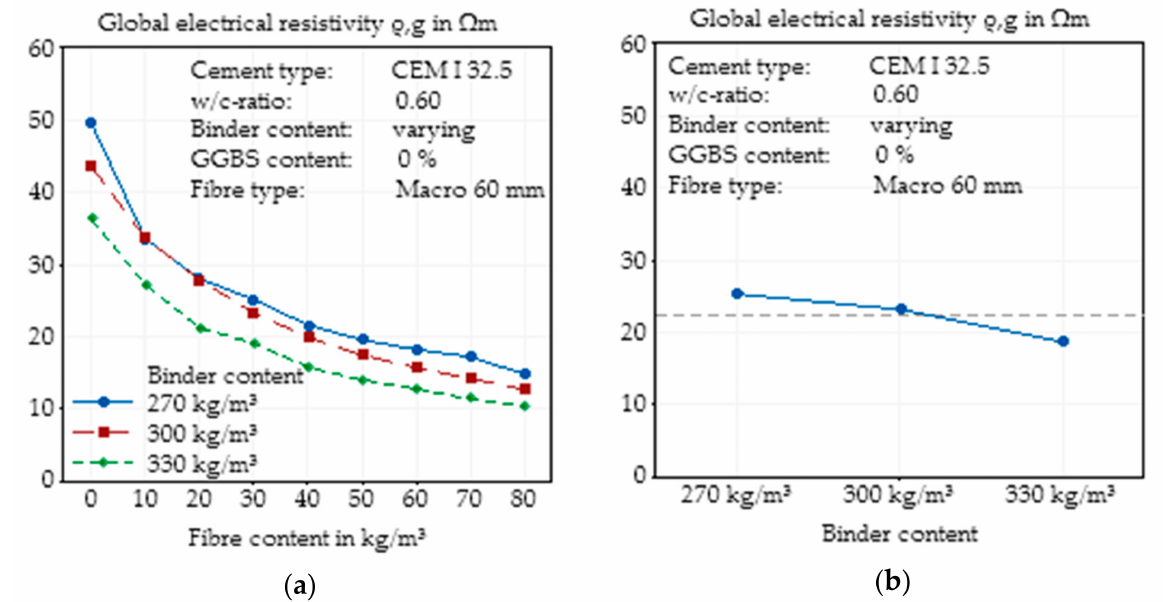
Figure 6. Effect of the binder content on the global electrical resistivity of SFRC as a function of fibre content ( a ) and main effect plot of the binder content on the global electrical resistivity of SFRC calculated by Minitab ( b